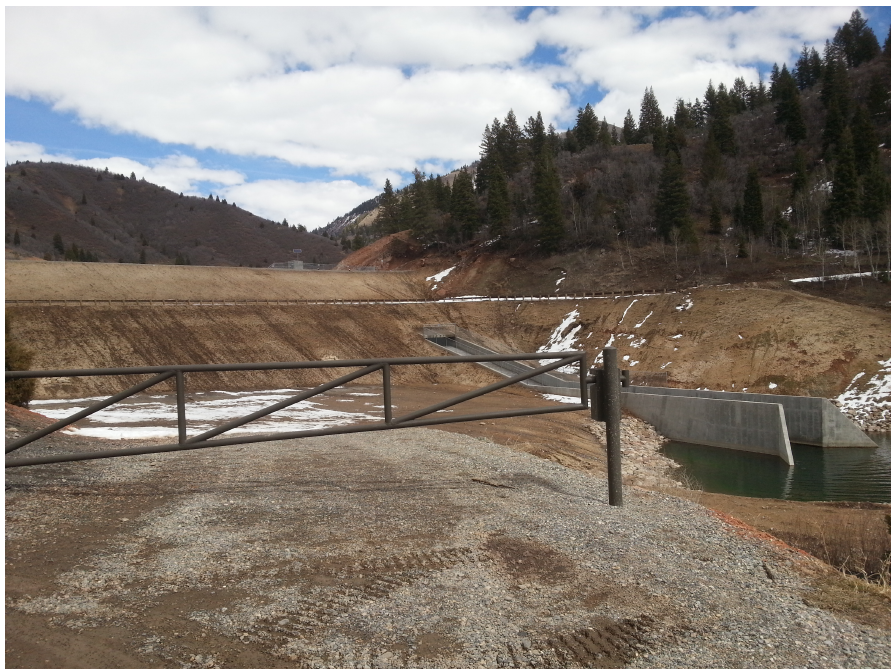
Figure 4. Tibble Fork Dam looking upstream.